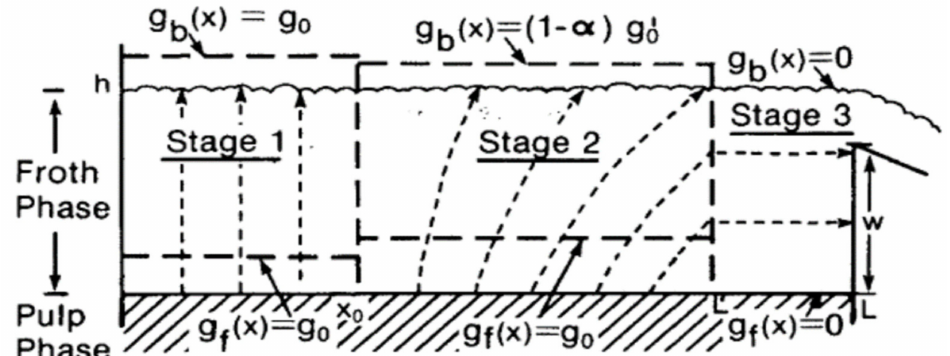
Figure 1. Two-stage tractable model [7] where w represents the height of the concentrate weir; h is the height of the froth; g f ( x ) is the flux of froth across the froth/pulp interface (cm/s); g b ( x ) is the flux of air through the froth surface resulting from bubble breakage; α is a froth stability parameter, which is defined as the ratio between the volumetric flow rate of air in the concentrate stream and the volumetric flow rate of air in the form of bubbles entering the froth phase, which have a non-zero probability of entering the concentrate